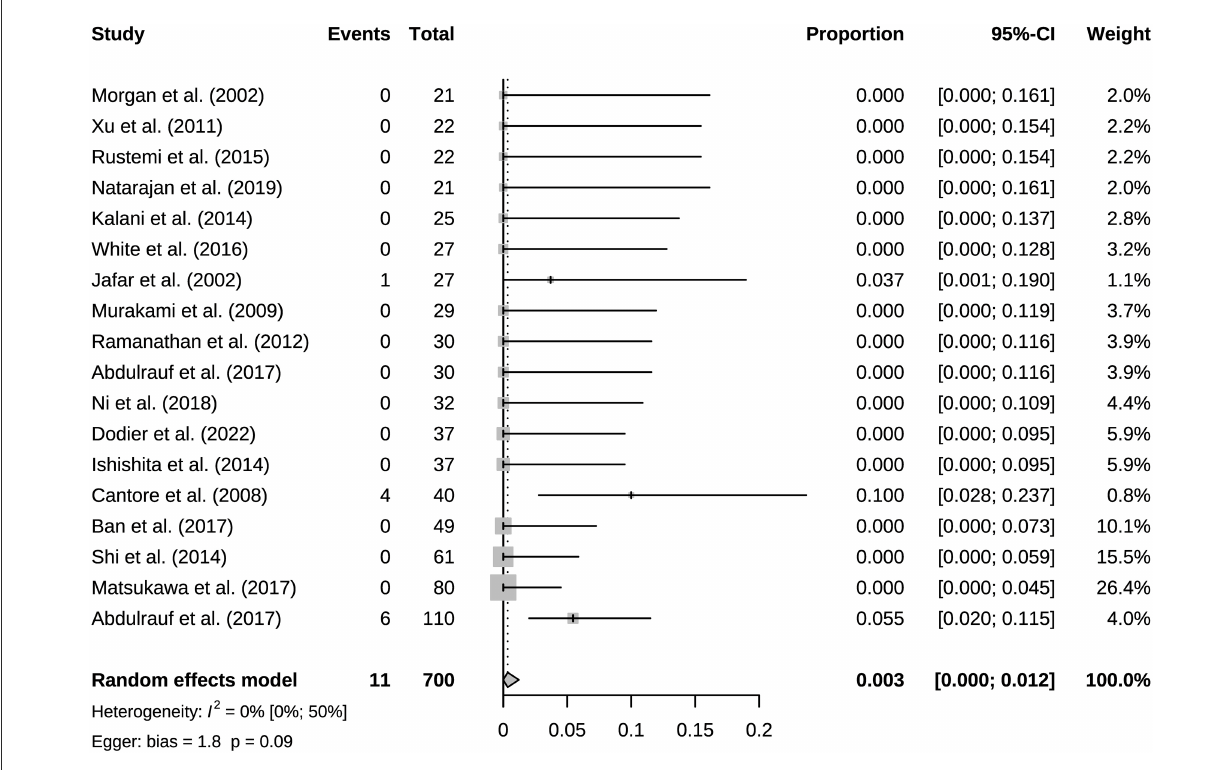
FIGURE6 Short-term follow-up surgery-related mortality of included studies.